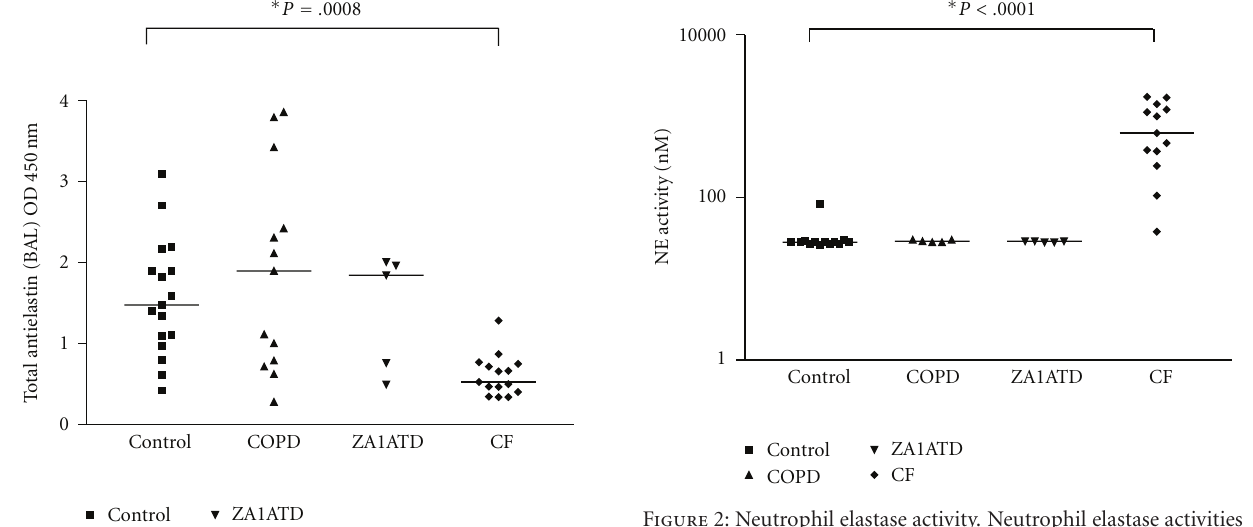
Figure 2: Neutrophil elastase activity. Neutrophil elastase activities were measured in bronchoalveolar lavage fluids of controls ( N = 8) or patients with COPD ( N = 5), Z-A1ATD ( N = 5) or CF ( N = 13) using N-methocysuccinyl-Ala-Ala-Pro-Val-p-nitroanilide.